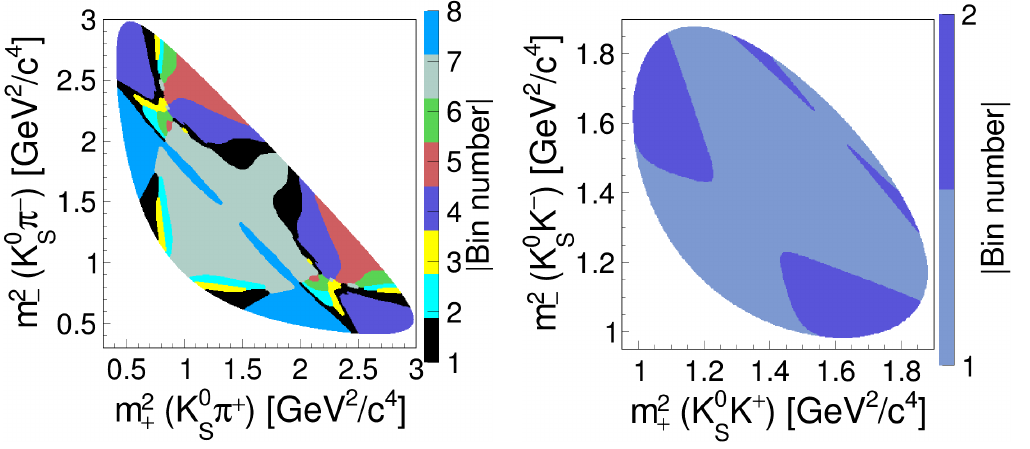
Figure 1 . Binning schemes used for (left) B + → D (cid:0) (cid:1) D K 0 K + K − K + S